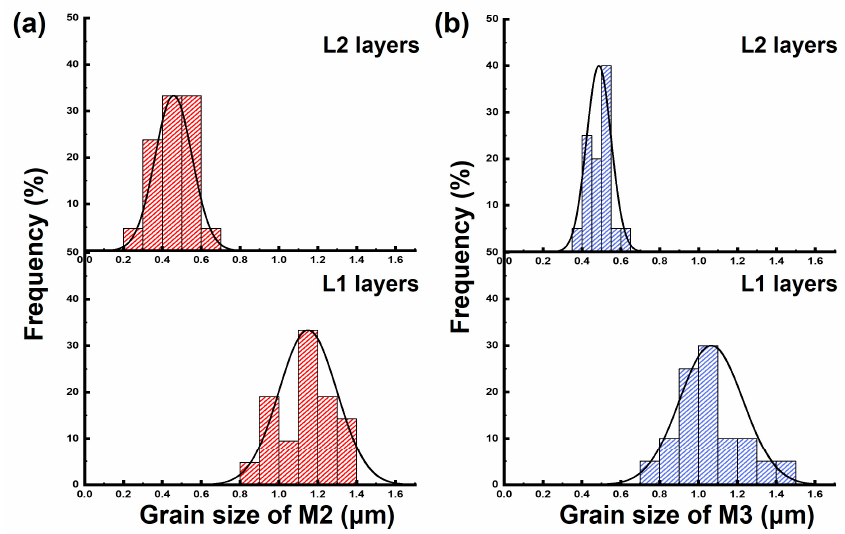
Figure 6. AGS distribution for the ( a ) M2 and the ( b ) M3 samples.